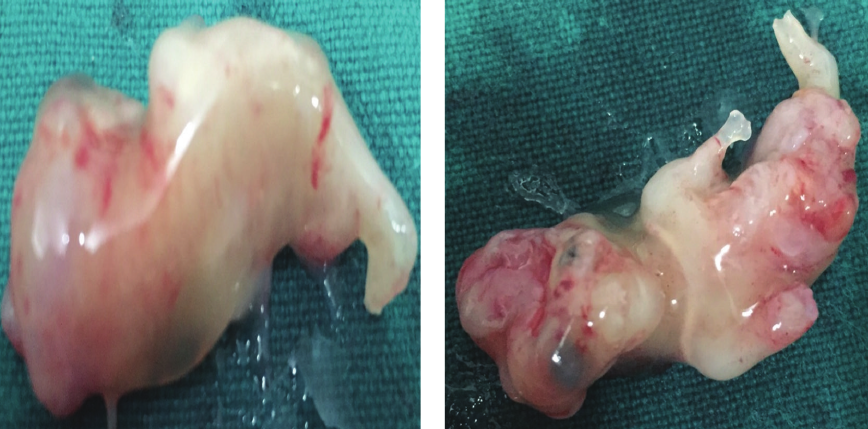
Figure 5: Showing aborted fetus of 11-12